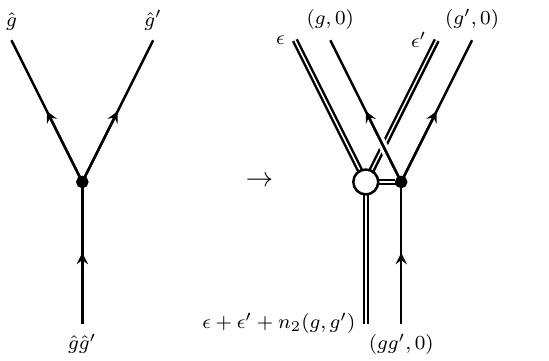
Figure 25 . We choose our basis for morphism space L basis for di(cid:11)erent ( (cid:15); (cid:15) 0 ) are related by crossing of a (cid:5) line as shown in the (cid:12)gure. Here a label (cid:15) adjacent to double line denotes that the double line is (cid:5) if (cid:15) = 1 and the double line is the identity line if (cid:15) =